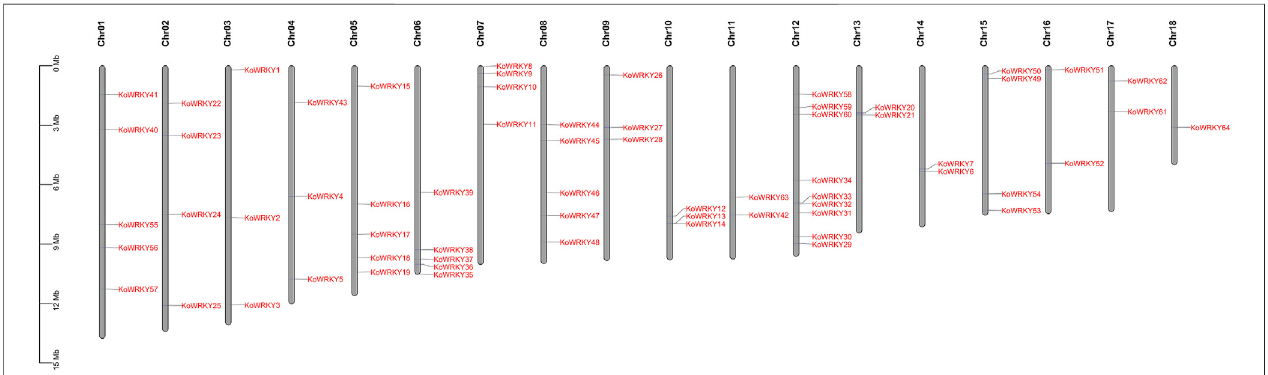
FIGURE 1 | Chromosomal distribution of KoWRKY genes. The position of each KoWRKY gene on the chromosomes can be determined by the left scale.